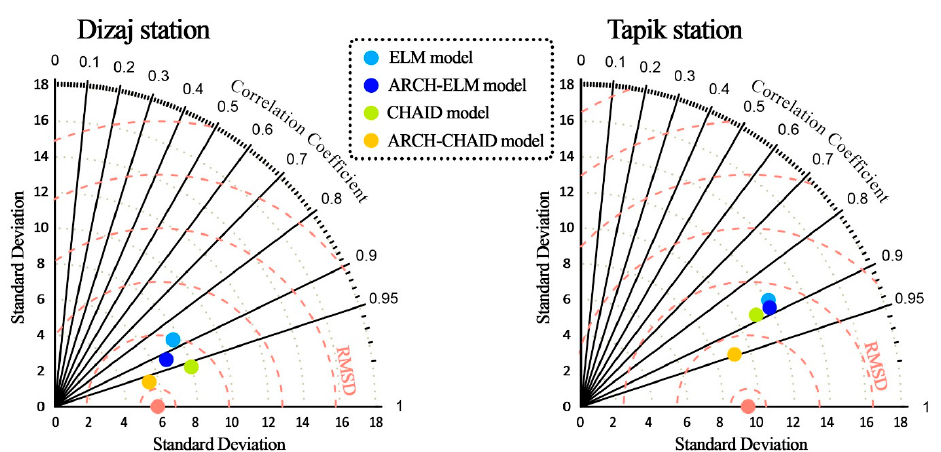
Figure 7. Taylor plots indicating the correlation coefficient and standard deviation in the validation stage based on the standalone OPELM and CHAID, vs. the hybrid ARCH-OPELM and ARCH-CHAID models for predicting monthly streamflow at two candidate study stations.